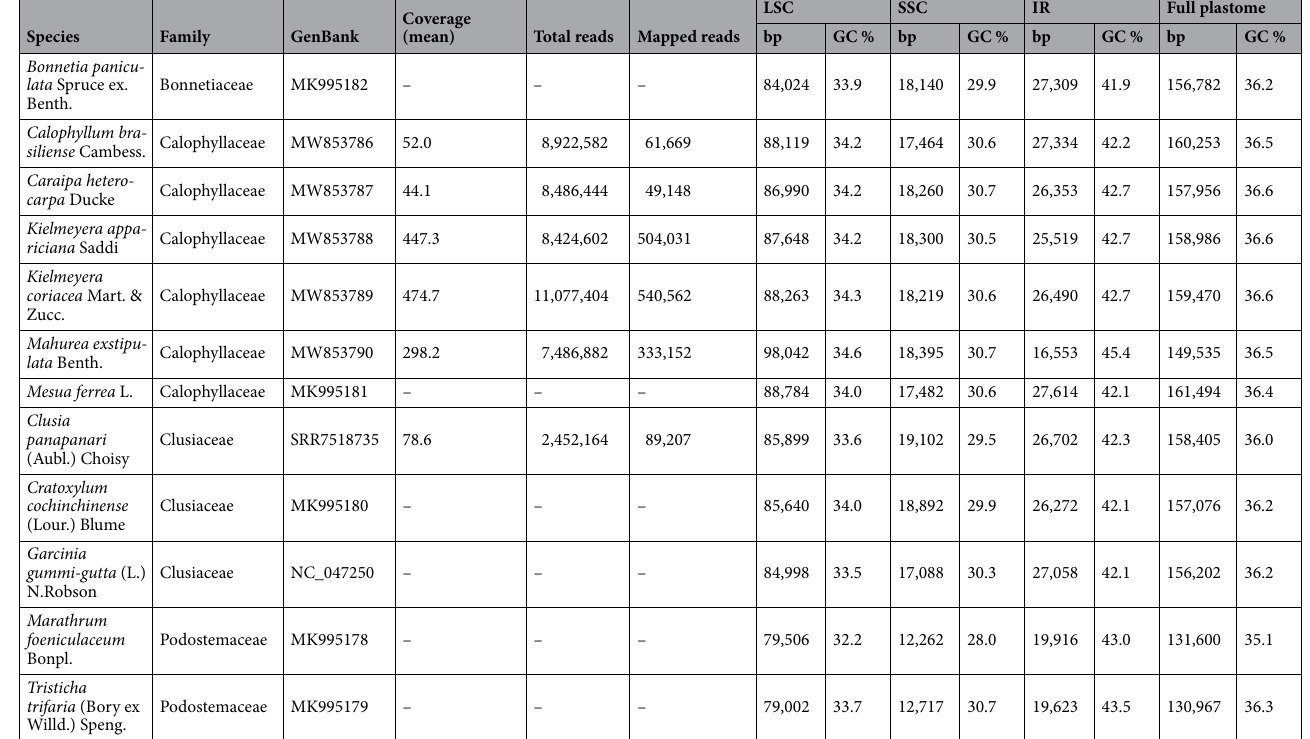
Table 1. GenBank accession numbers and comparison of chloroplast genome size and GC content across three different regions (LSC, SSC, and IR) for 12 clusioid species. LSC large single copy, SSC small single copy, IR inverted repeat.